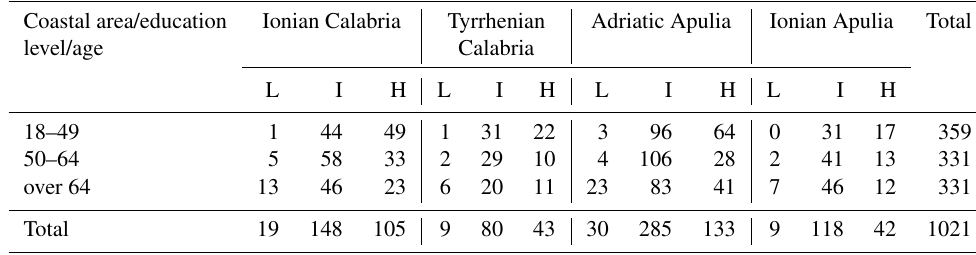
Table 2. Sample of the survey for age, gender, coastal area and educational level. Coastal area/education